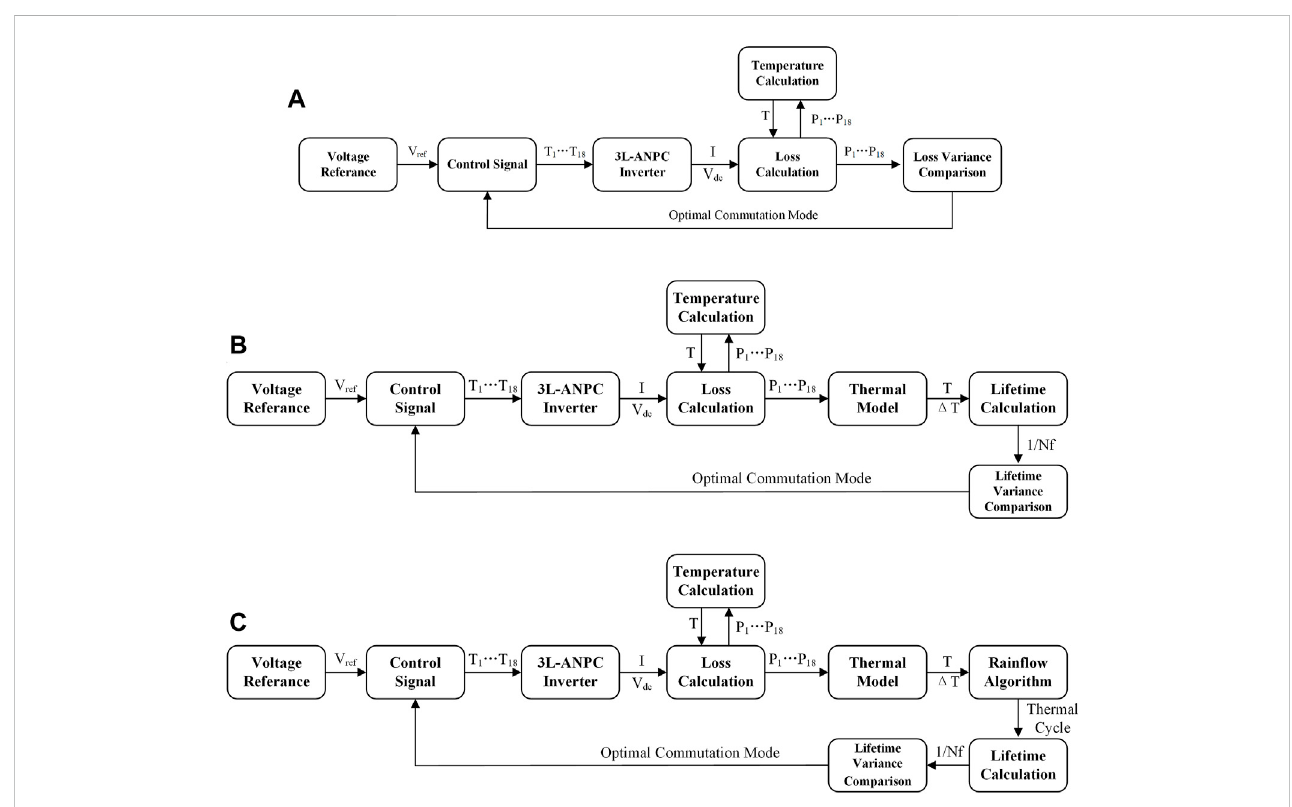
Control diagram based on balancing loss and lifetime distribution. (A) Constant load. (B) Periodic load. (C) Random